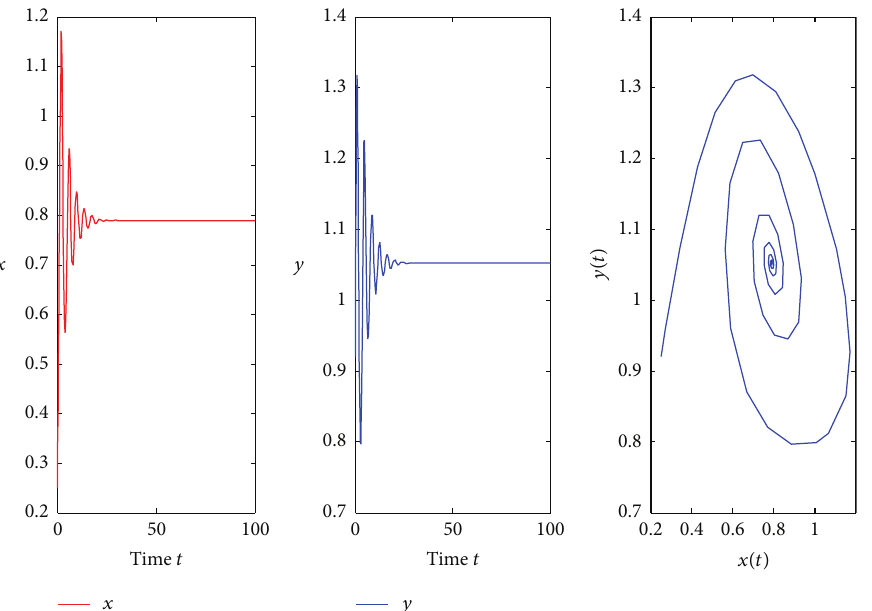
Figure 5: 𝐸 ∗ is asymptotically stable for 𝜏 2 = 0.5, 𝜏 1 = 0.86 < 𝜏 ∗ 10 = 1.0931 with initial values “0.25;0.92.”